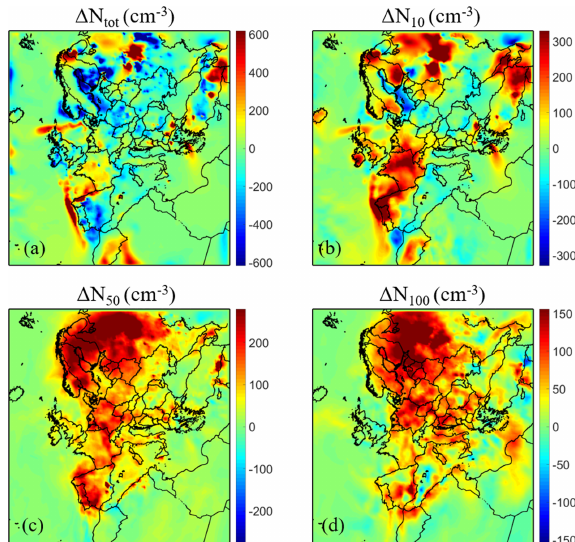
Figure 5. Average ground level increase in number concentration (in cm − 3 ) due to the condensation of ELVOCs for (a) all particles ( (cid:49)N tot ), particles above (b) 10nm ( (cid:49)N 10 ), (c) 50nm ( (cid:49)N 50 ), and (d) 100nm ( (cid:49)N 100 ). Different scales are